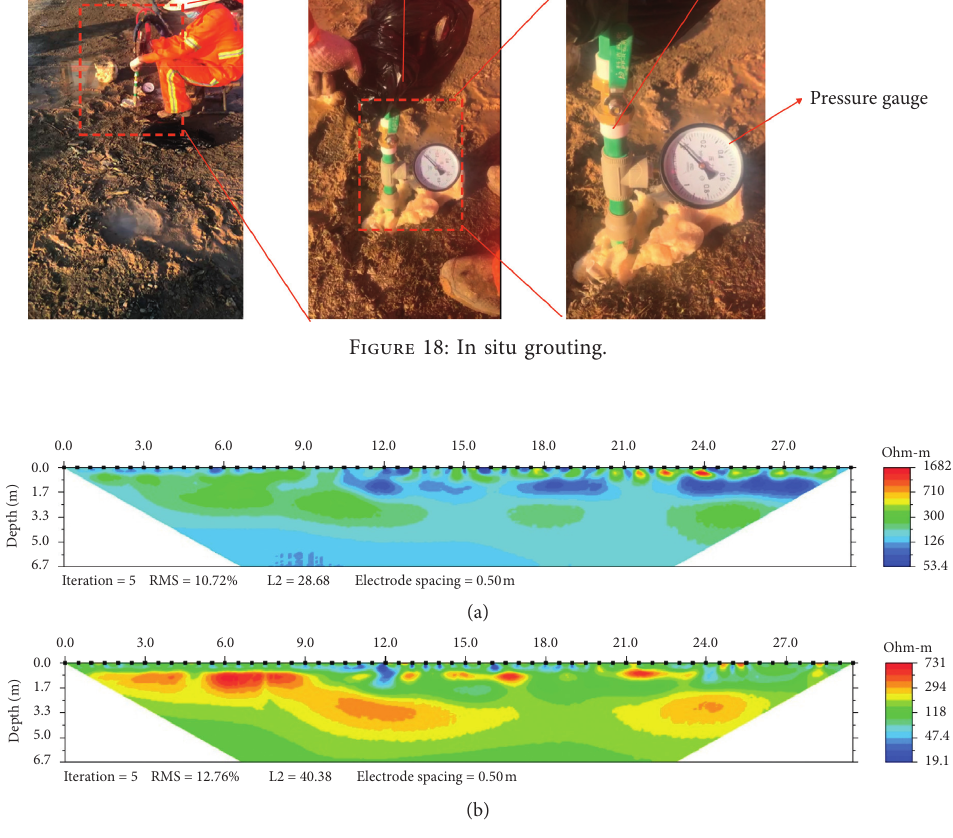
Figure 19: High-density electrical detection results. (a) Before grouting. (b) After